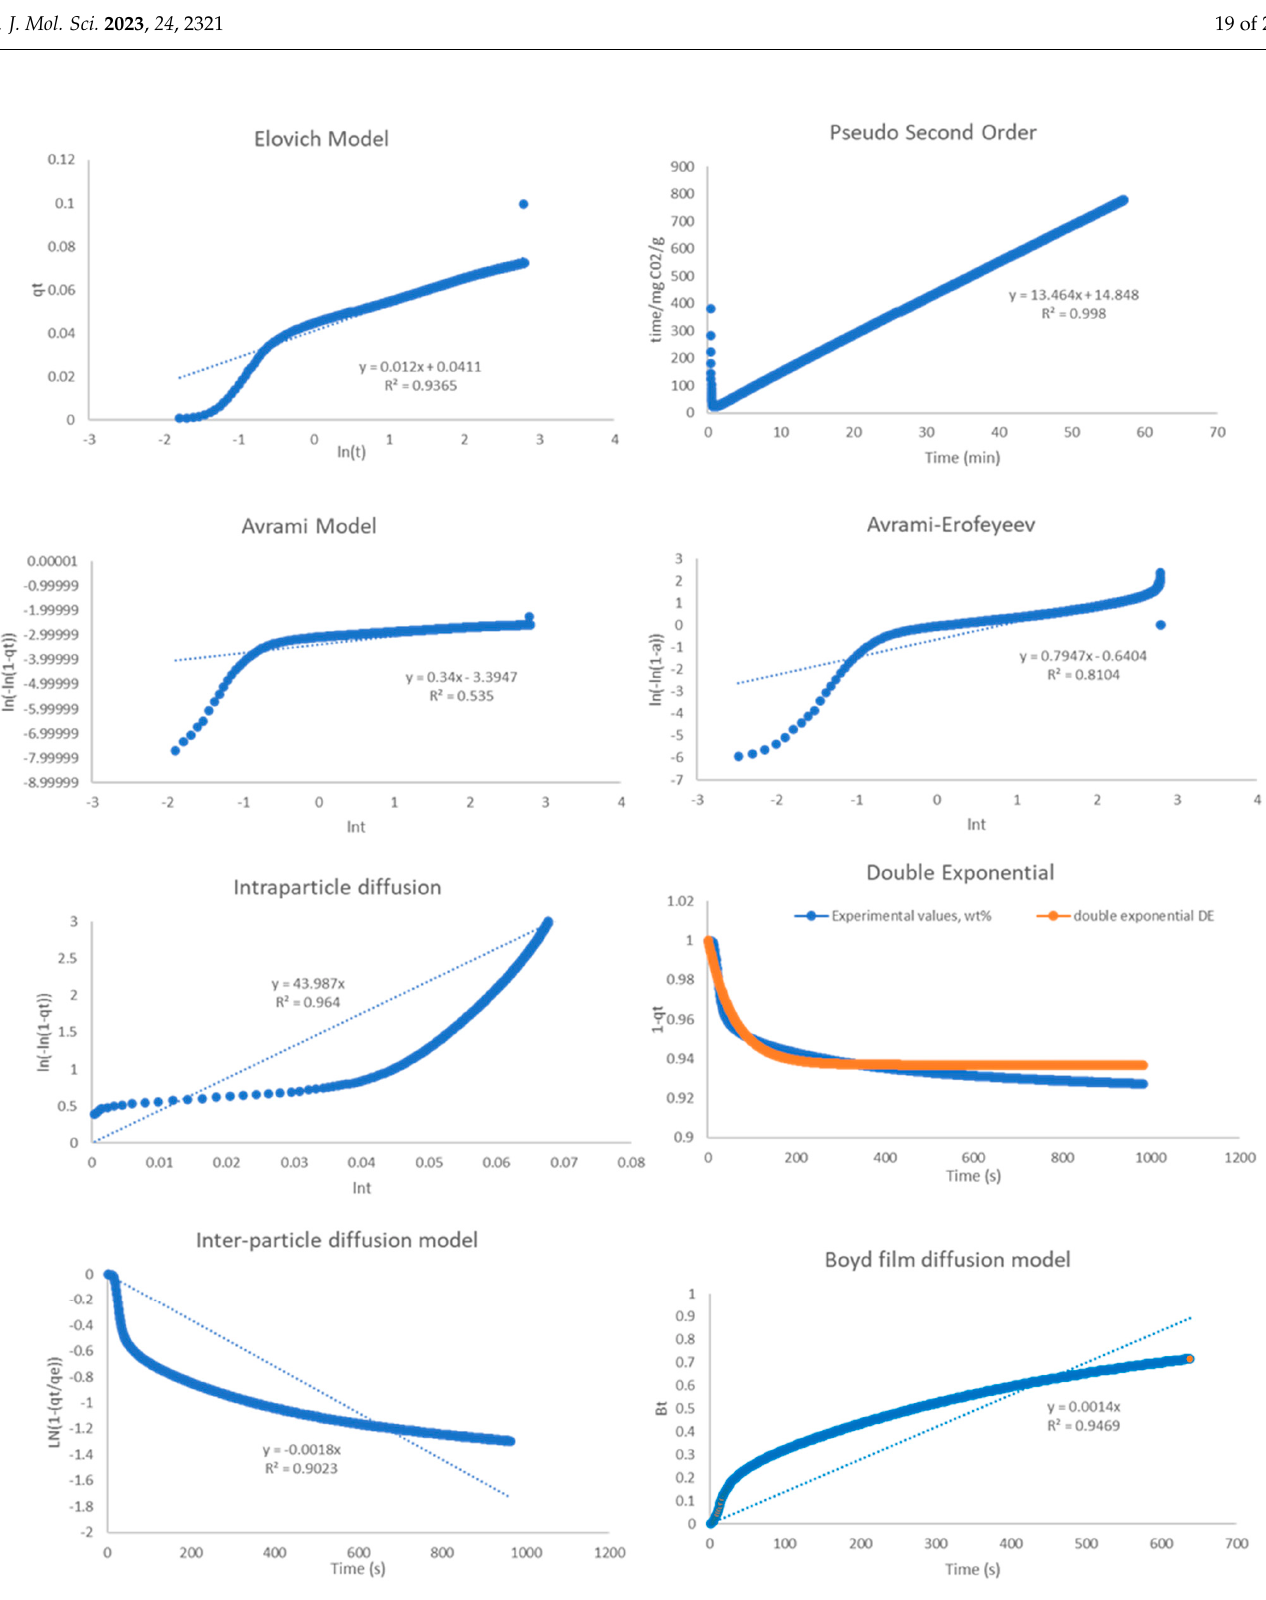
Figure A4. Kinetic modelling at 800 °C.